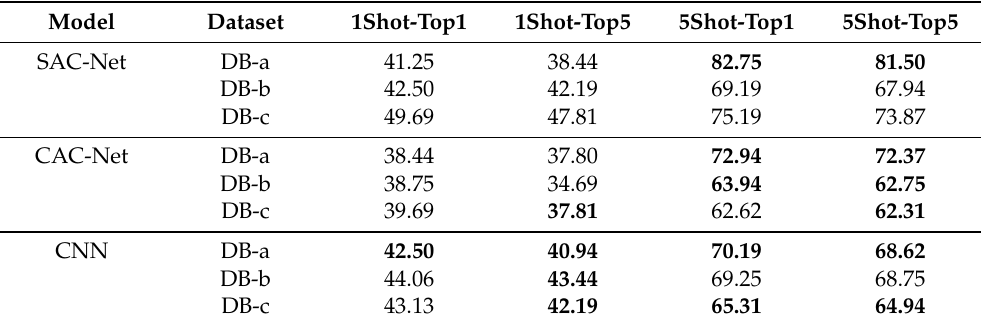
Table 11. 5-way 1-shot and 5-way 5-shot classification with different models on new subject on CapgMyo with MAML. The meta batch size is set to 64. The boldface numbers represent the best classification accuracies for each model and dataset compared with Table